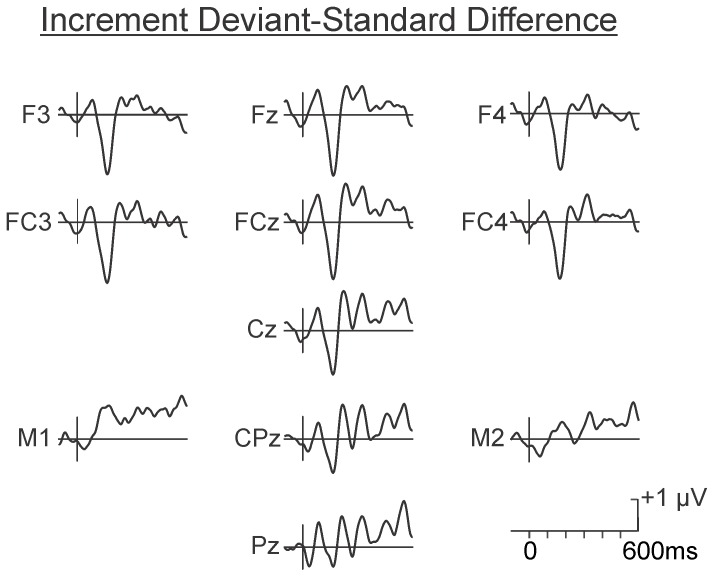
Grand average difference waves in the psychological increment condition.A large amplitude front-central maximum MMN occurring between 150 and 200 ms was evident following presentation of the psychological increment. A significant P3a-like centro-frontal maximum positivity peaking between 200 and 250 ms was also evident in the grand average waveform.